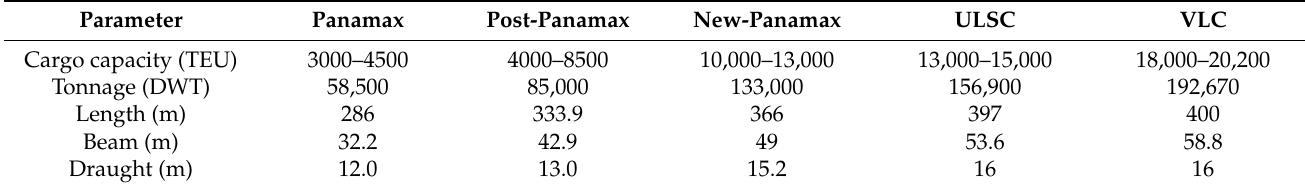
Table 1. Different types of container